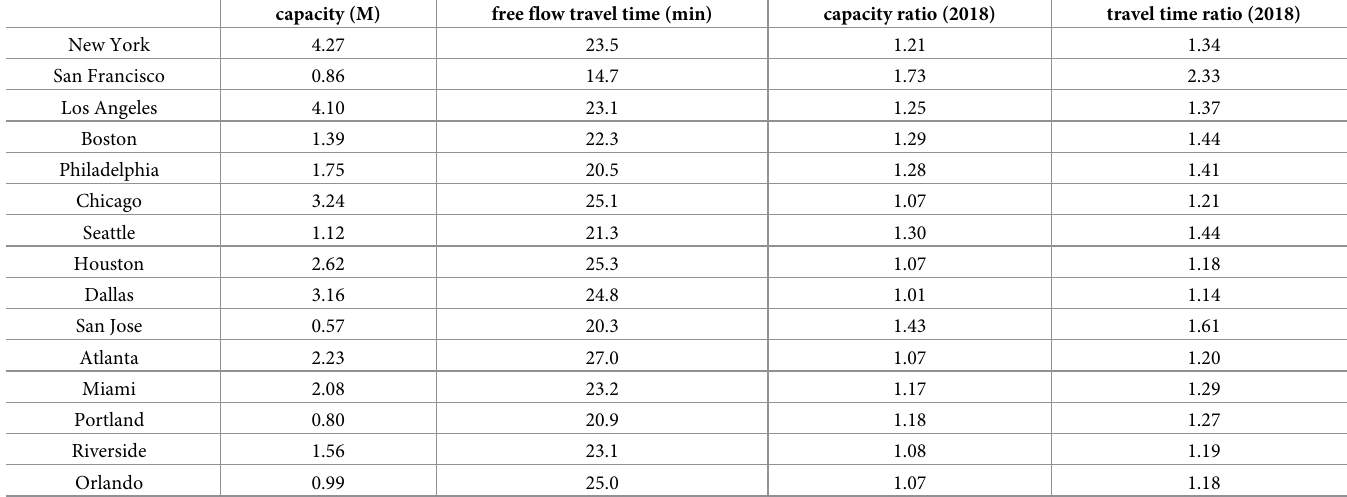
Table 4. Estimated model parameters, capacity ratio, and travel time ratio for 15 metro areas. (See also S4 Table for all 74 modeled metro